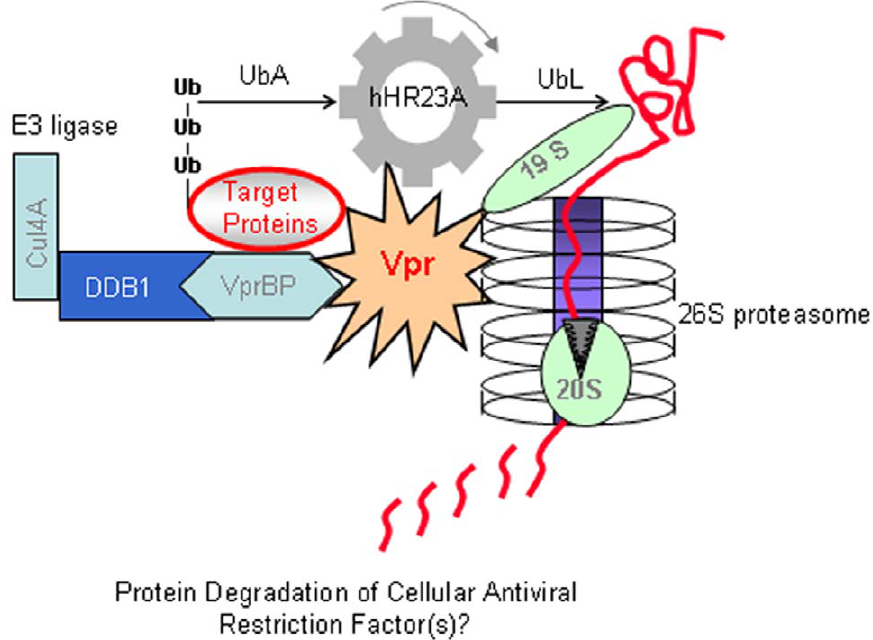
Figure 4. Proposed model of Vpr-proteasome interactions. Details are in the text.